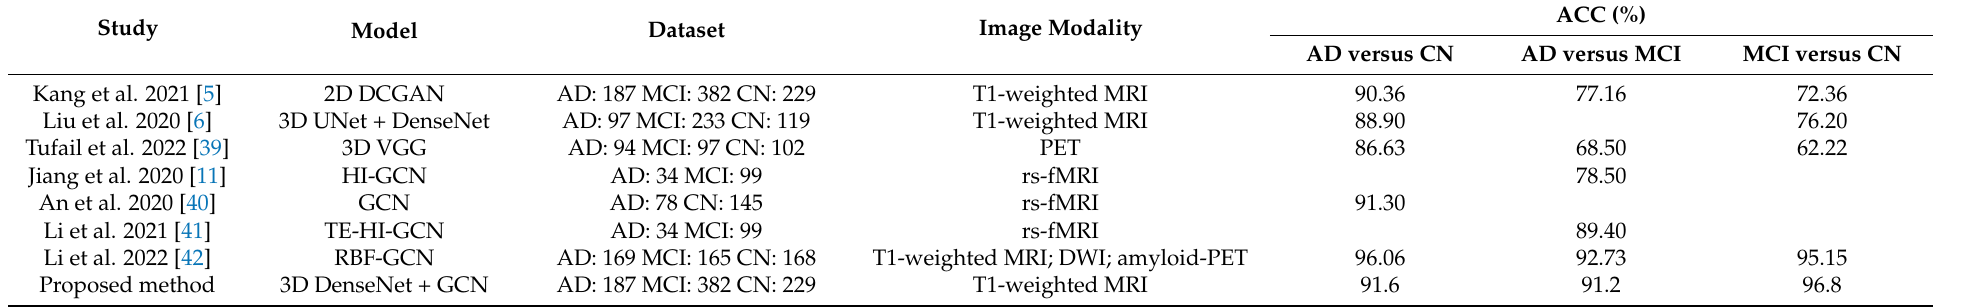
Table 6. Comparison of the proposed models with the state-of-the-art